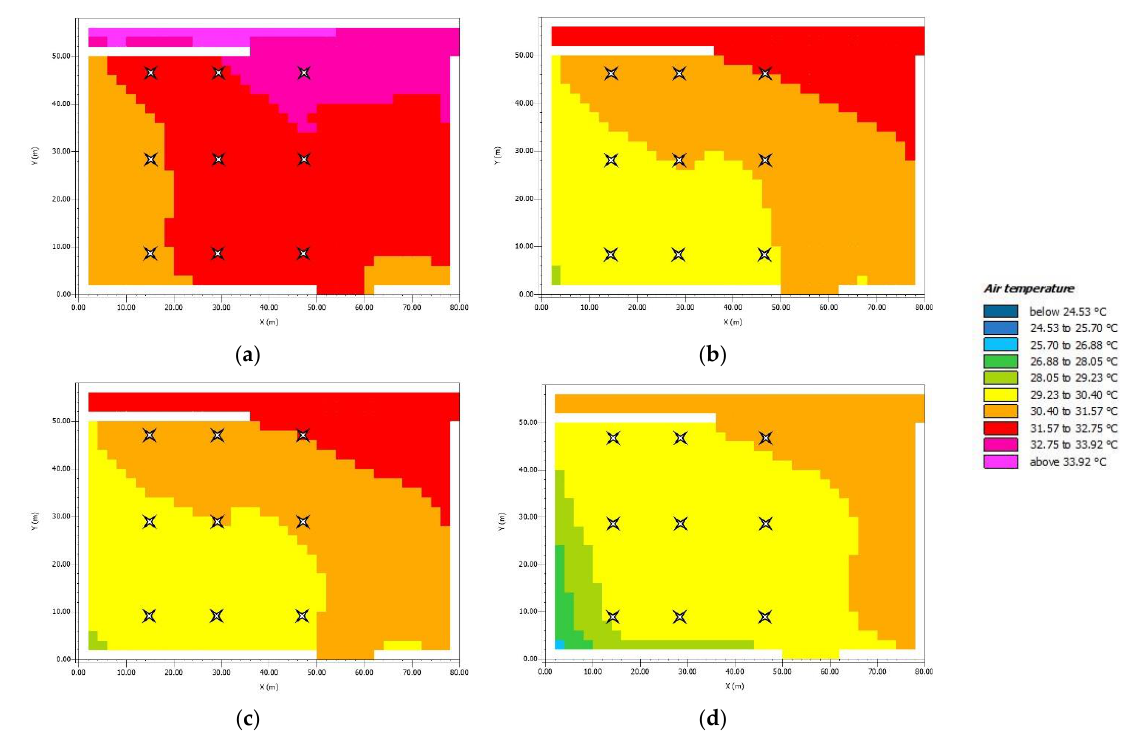
Figure 8. AT at 04.00 p.m. in July. ( a ) AS; ( b ) LC+G1; ( c ) LC+G2; ( d )